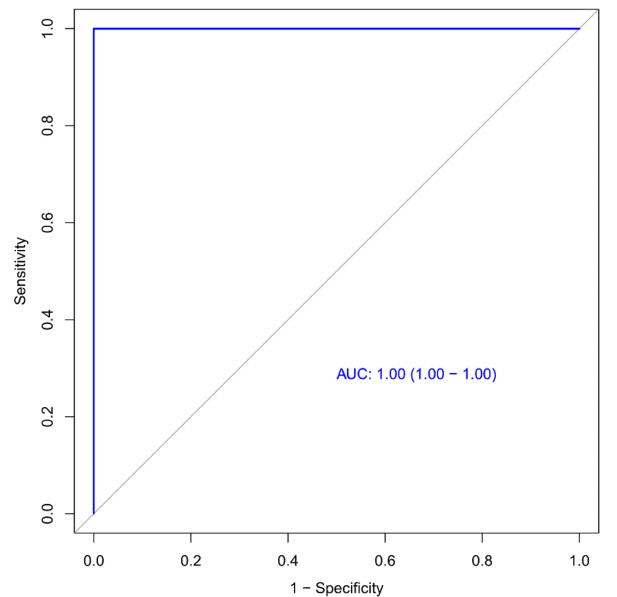
Figure 11. Receiver operating characteristic (ROC) curve for the second model. The AUC (area under the ROC) was 1.00 for the